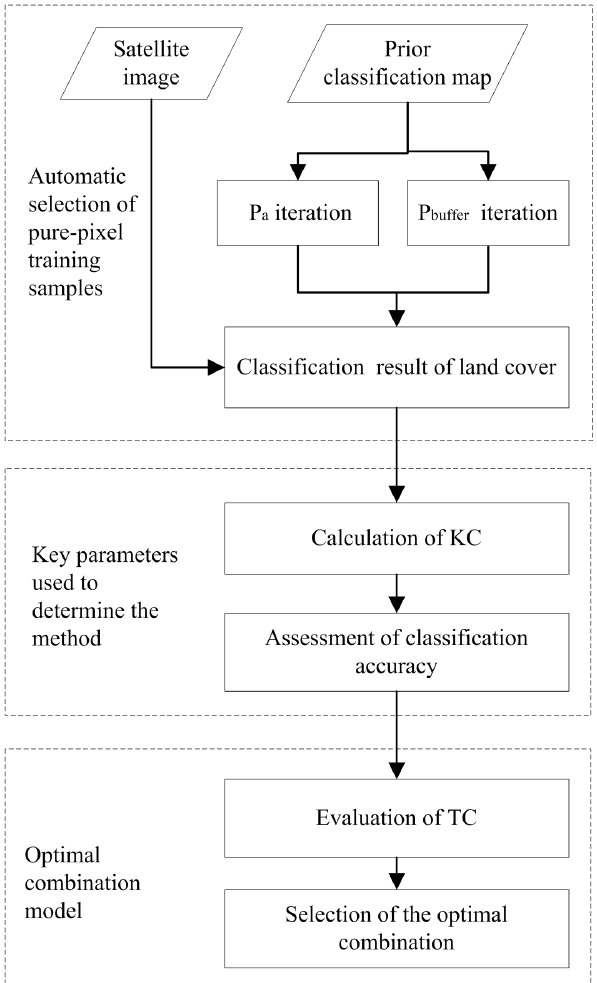
Figure 1. General flowchart of proposed approach (KC: Kappa Coefficient; TC: Time-Consuming).